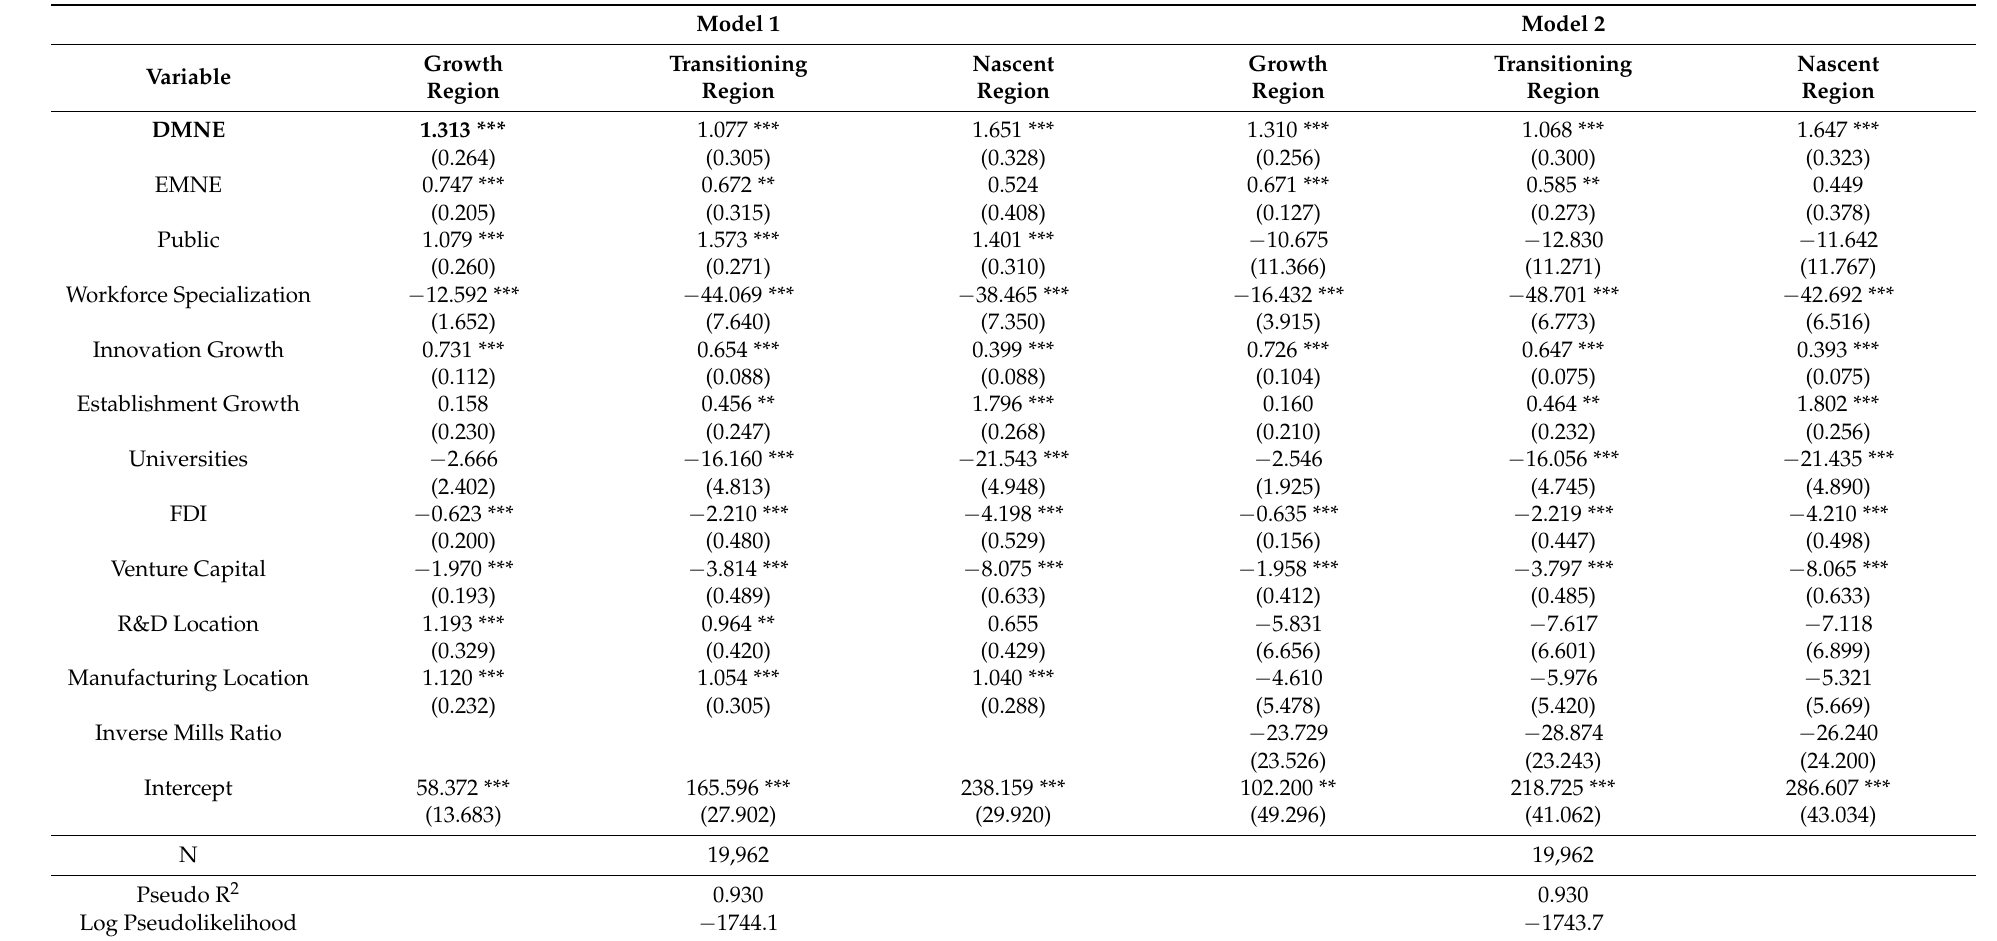
Table 4. Multinomial logistic regression